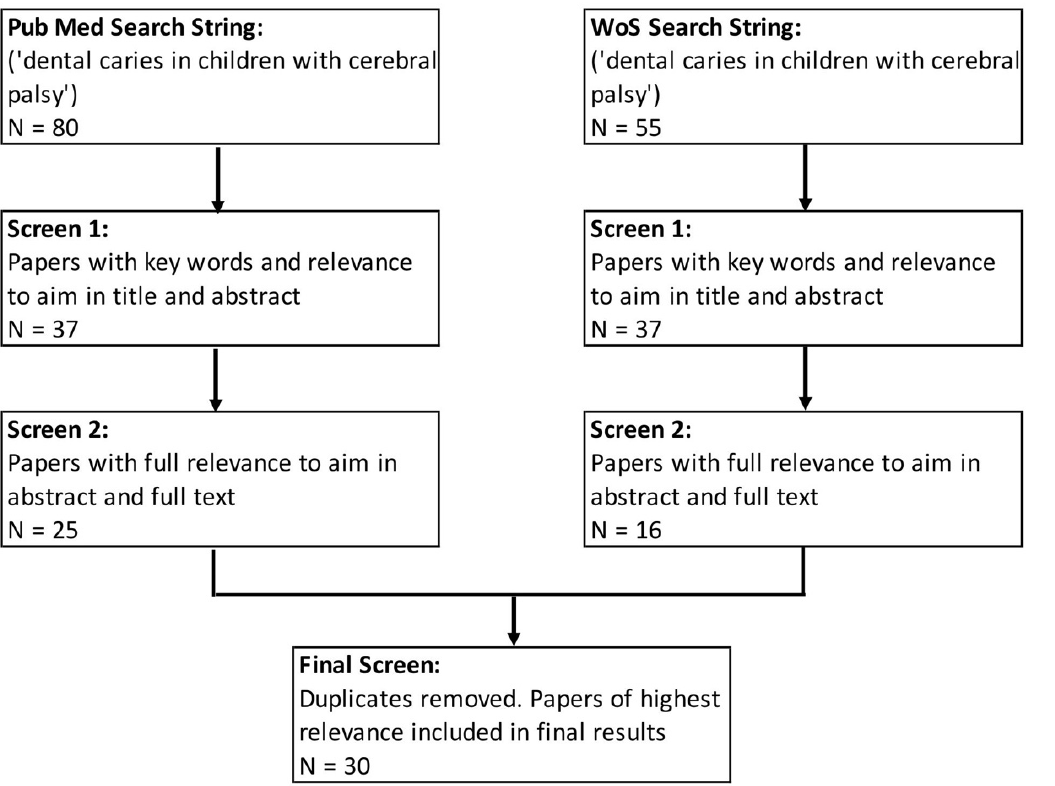
Figure 1. Details of the screening process employed using search engines, Web of Science (WoS) and PubMed and 10 different key words are shown. With each successive step, a screen was performed, narrowing the selection of papers based on highest relevance.